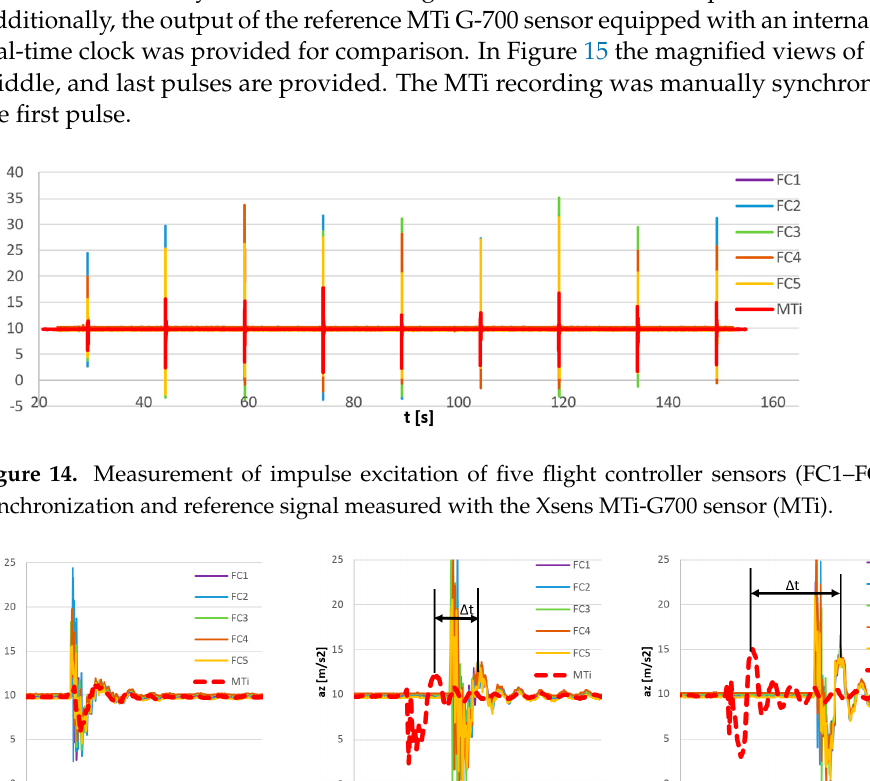
Figure 14. Measurement of impulse excitation of five flight controller sensors (FC1–FC5) after syn- chronization and reference signal measured with the Xsens MTi-G700 sensor (MTi).